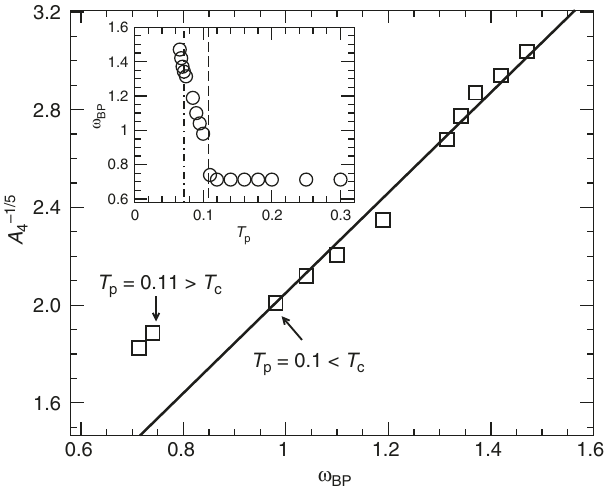
Fig. 6 Scaling of the boson peak frequency. The characteristic frequency A (cid:2) 1 = 5 versus the boson peak position ω BP . The line is a fi t A (cid:2) 1 = 5 4 glasses whose T p < T c , which is the parent temperature range where we see an increase in ω BP with decreasing T p , see inset where the vertical dashed- dotted, dashed lines mark the positions of T g and T c , respectively